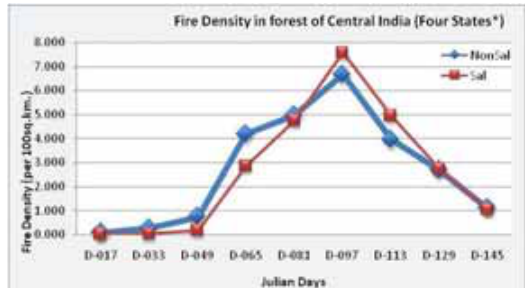
Figure-9: Fire regimes of Non Sal dominated regions over central